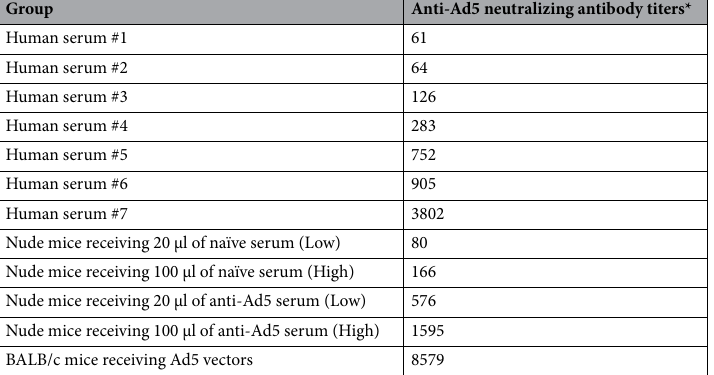
Table 1. The neutralizing antibody titers following the transfer of anti-Ad5 serum. *Neutralizing anti-Ad5 antibody titers were determined by the serum dilution factor that showed a 50% reduction in luciferase production of Ad-L2 at 500 VP/cell on H1299 cells, compared with the serum-free group at 2 days after